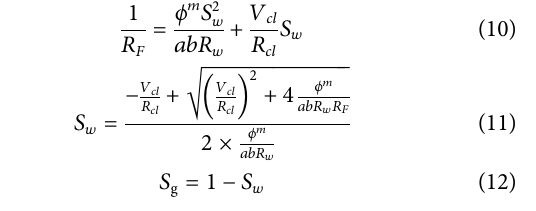
Frontiers in Earth Science |